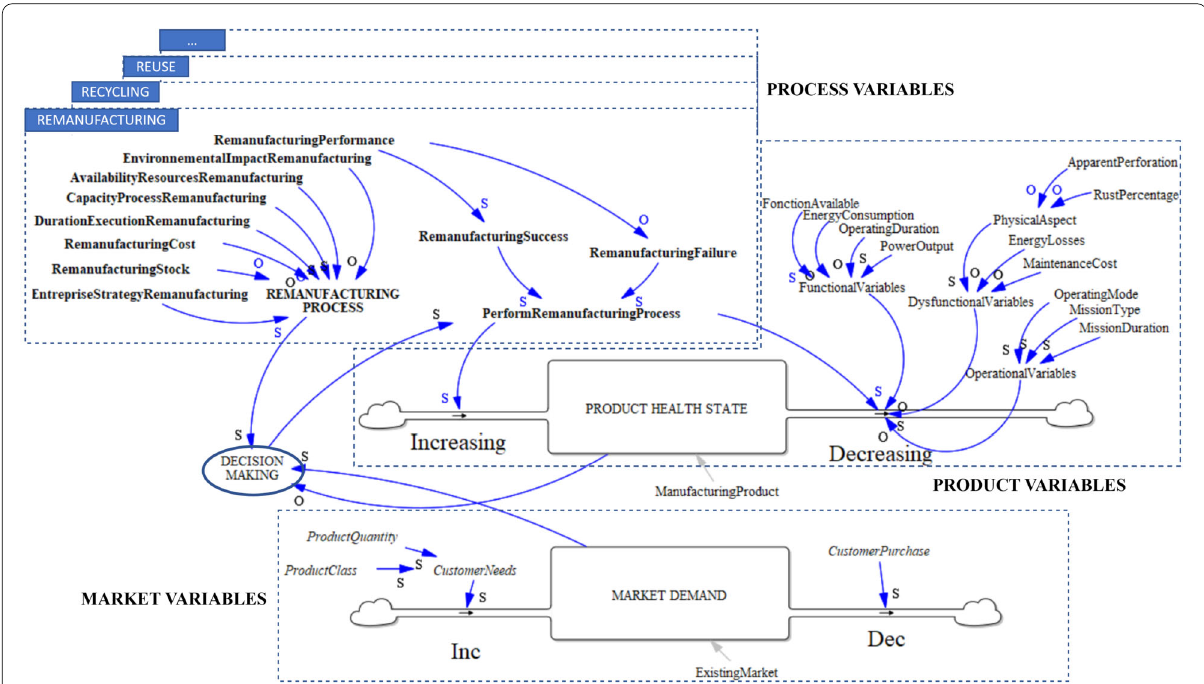
Figure 2 Causal diagram of product, process and market variables impacting decision